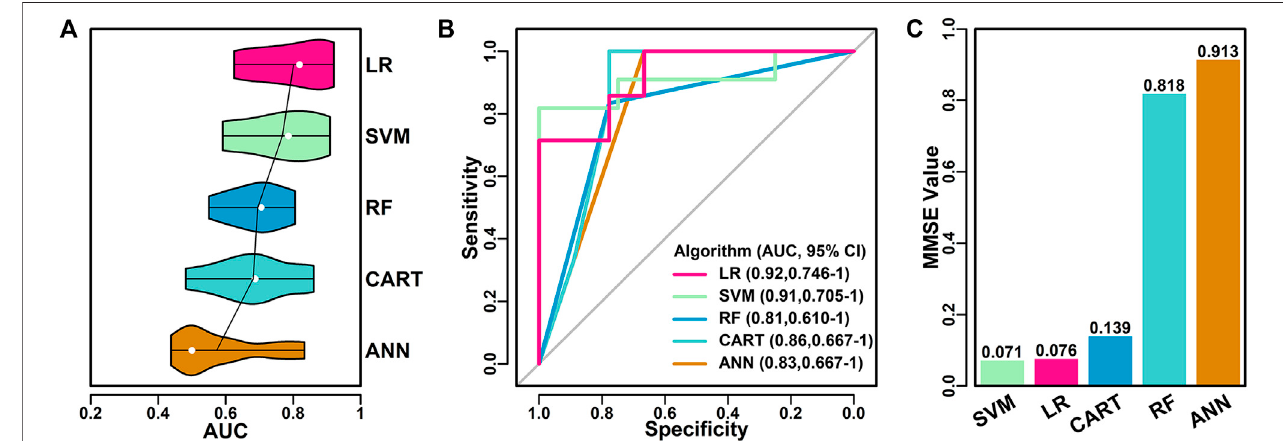
FIGURE 4 | Performance of fi nal classi fi er models. (A) Performance of fi ve models using different algorithms with top six features as input. The mean AUC scores were highlighted in lines and the median AUC scores were highlighted in white dot. (B) ROC curves of different models. (C) NMSE values of different